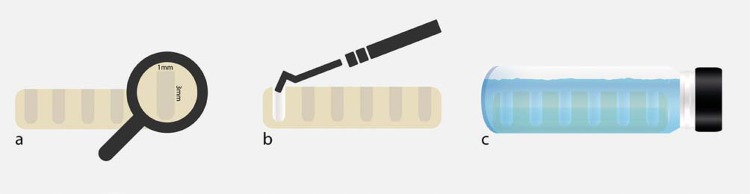
Schematic figure representing the volumetric change assessment [A-Transparent acrylic resin-based models with cavities measuring 3 mm deep and 1 mm in diameter (n=6), B- Cavities filled with each material using a condenser and C- Samples immersed in distilled water between the experimental time intervals (7 and 30 days)]